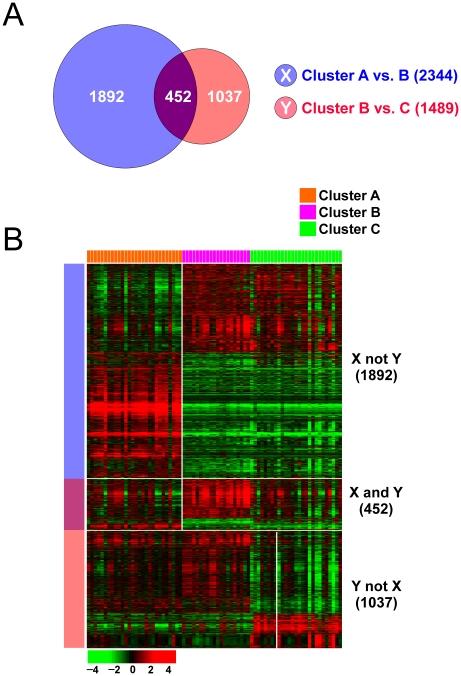
Cross comparison of gene lists from two independent statistical tests.(A) Venn Diagram of genes differentially expressed. The blue circle (gene list X) represents genes differentially expressed between cluster A and B. The red circle (gene list Y) represents genes differentially expressed between cluster B and C. Four-hundred-fifty-two genes were shared by the two gene lists. We applied a cut-off P-value of less than 0.002 to retain genes whose expression is significantly different between the two groups of tissues examined. (B) Heat map of gene expression patterns. Blue and pink bars on the left side of the heat map represent each selected genes. Colored bars at the top of the heat map represent the tissues indicated. Expression of genes in the X not Y category was dramatically different between clusters A and B as well as between clusters A and C, but almost no differences were observed between clusters B and C, signifying a unique gene expression signature that distinguishes patients in cluster A from the rest of the patients.